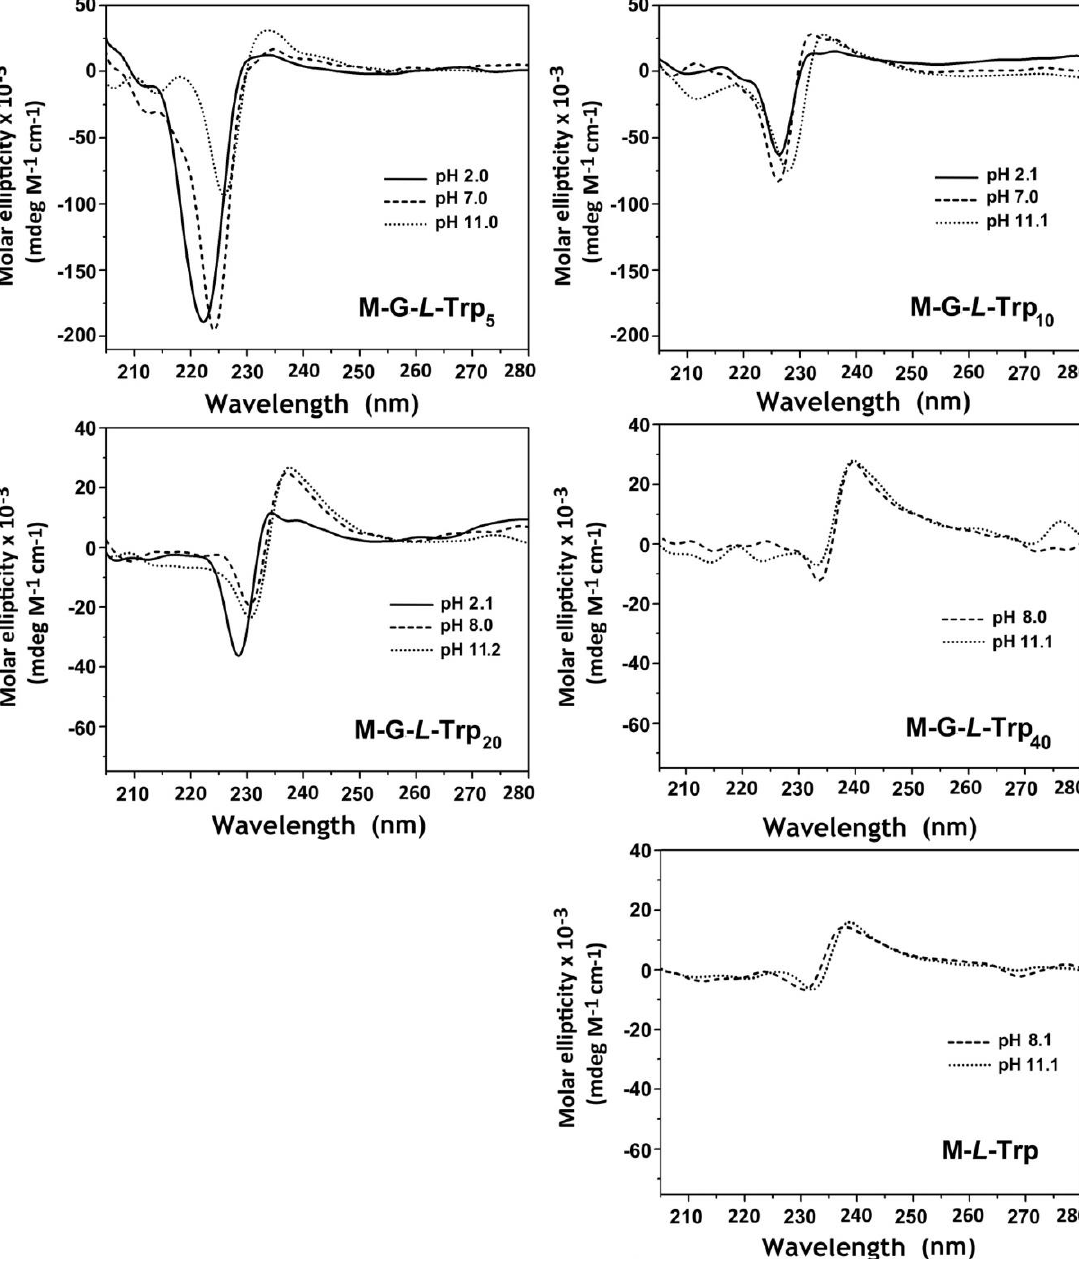
Figure 7. pH-Dependence of M-G- L -Trp CD spectra. Data were obtained in 0.1 M NaCl solution at 25 °C. The overall concentration of the repeating units was 1.81 ± 0.25 mM. The curves were normalized accounting for the molar concentration of tryptophan units.